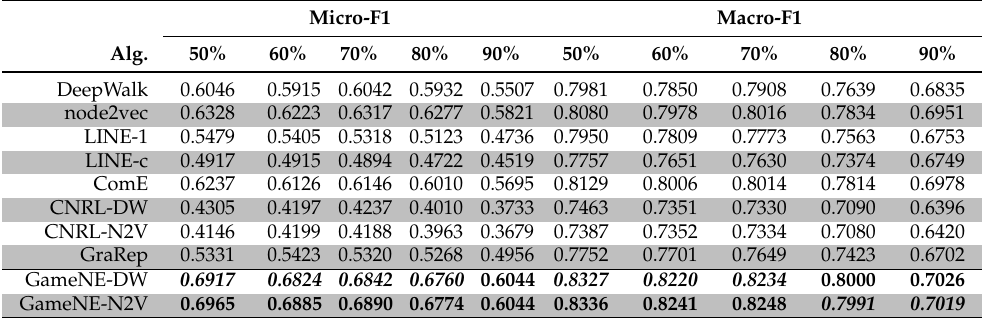
Table 5. Micro- and Macro-F1 Scores of Multi-Label Classification, Network om = 9.